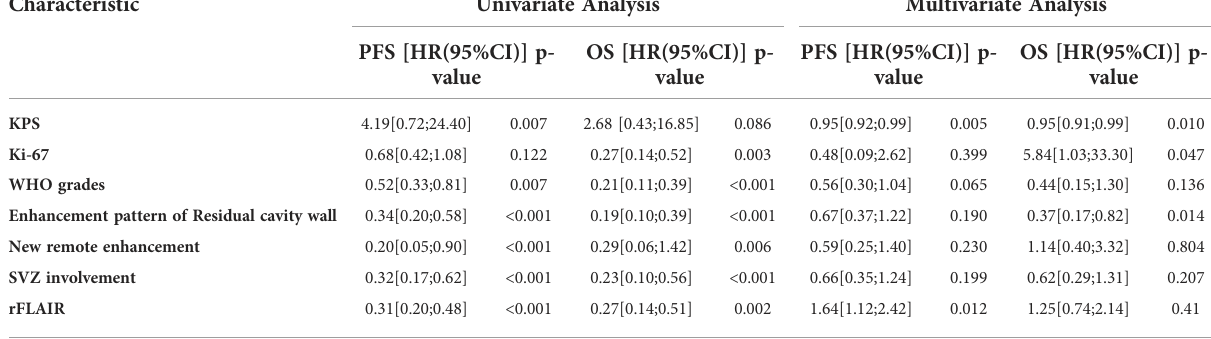
TABLE 3 Survival analysis of patients with LGG: univariate and multivariate